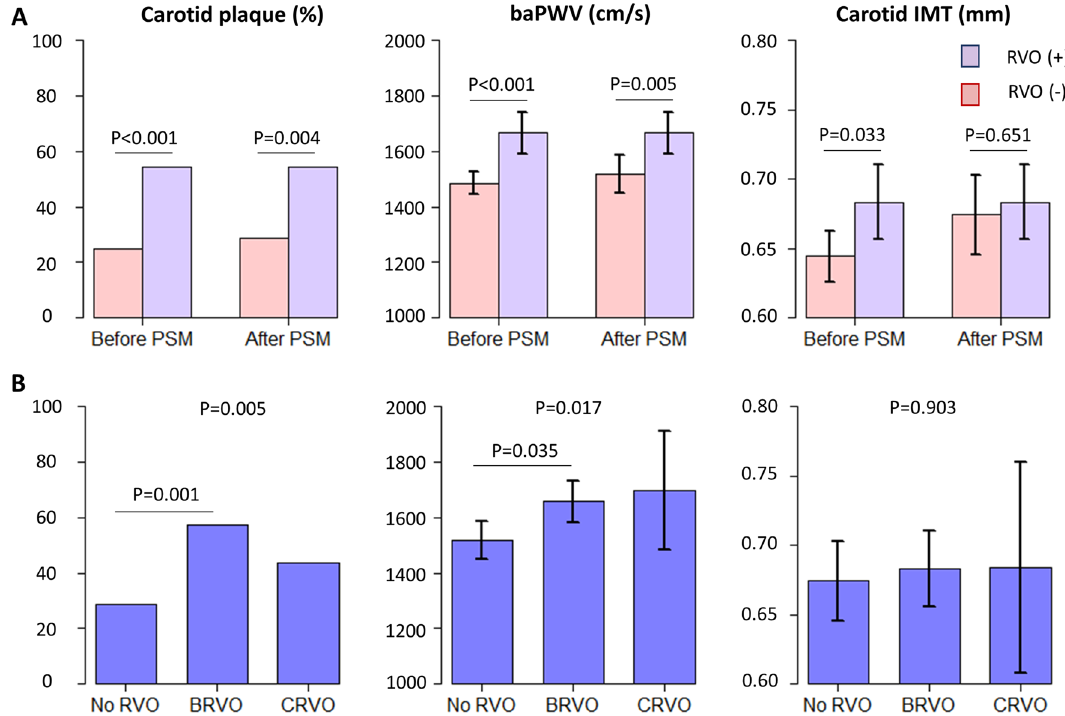
Figure 2. Markers of subclinical atherosclerosis in patients with and without RVO. ( A ) The frequencies of carotid plaque and baPWVs were higher in patients with RVO than in those without RVO in both matched and unmatched cohorts, whereas the carotid IMT was not different between the two groups in the matched cohort. ( B ) In the matched cohort, patients with BRVO had higher frequencies of carotid plaque and higher baPWV levels than those without RVO, whereas the frequencies of carotid plaque and baPWVs were not different between the patients with CRVO and those without RVO. The carotid IMT was not different among the three groups. This figure was created using R with the “graphics” package (R Core Team, 2020) 15 . baPWV brachial-